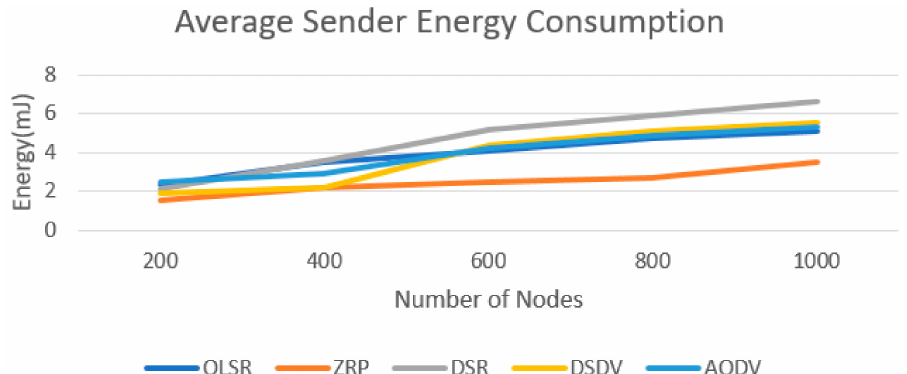
Figure 6. Comparative analysis of average sender energy consumption in 200–1000-node networks using the proposed scheme over five MANET routing protocols.